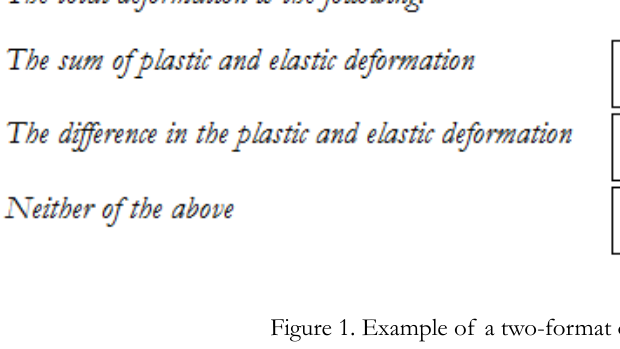
Figure 1. Example of a two-format